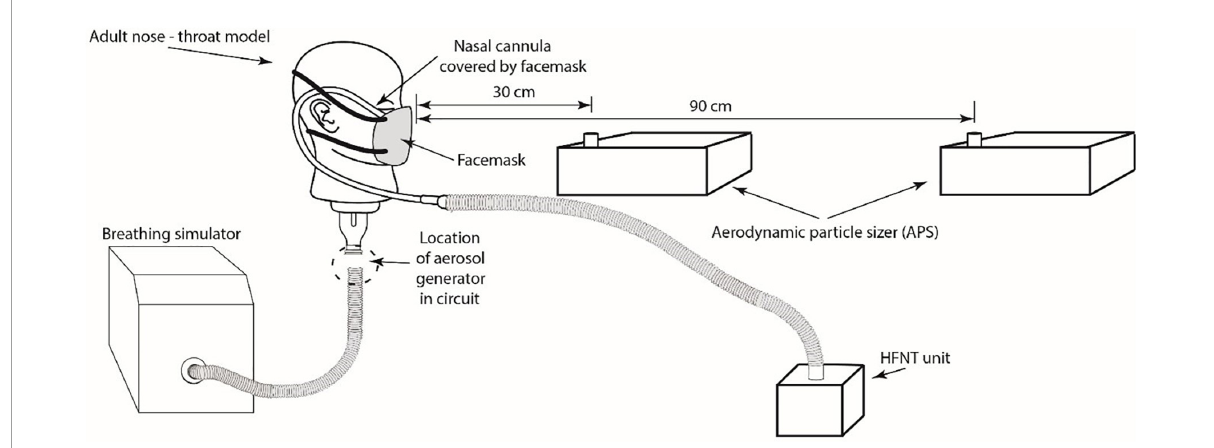
FIGURE1 Illustration of an in vitro model with HFNC interface and surgical facemask with the APS positioned at 30 and 90 cm distance relative to the head model. Note, test combinations were examined with and without a standard surgical facemask on the adult nose-throat